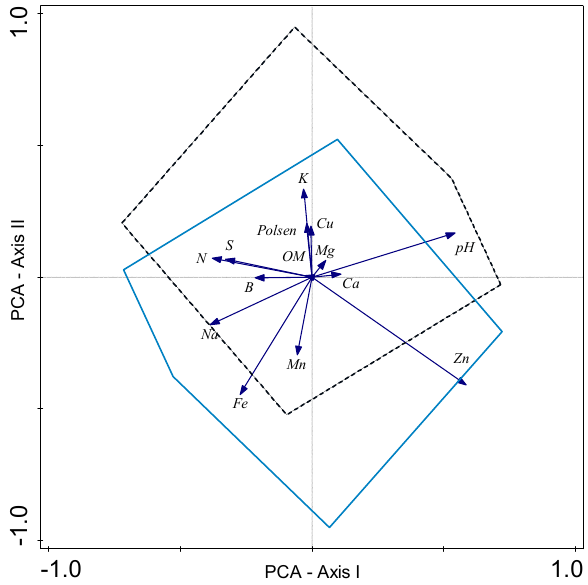
Figure 5. Principal components analysis (PCA) of the soil samples of the pairs of plots in 2021 and soil nutrient variables. Variables used appear as arrows, while control plots are enclosed in a black dashed line, and exclusion plots are enclosed in a blue solid line. The matrix used for this analysis appears in appendix II (eigenvalue for axis I: 0.08, eigenvalue for axis II: 0.05, cumulative percentage of variance explained for axes I and II: 63.4%). Species scores and polygons enclosing control vs. exclusion plots